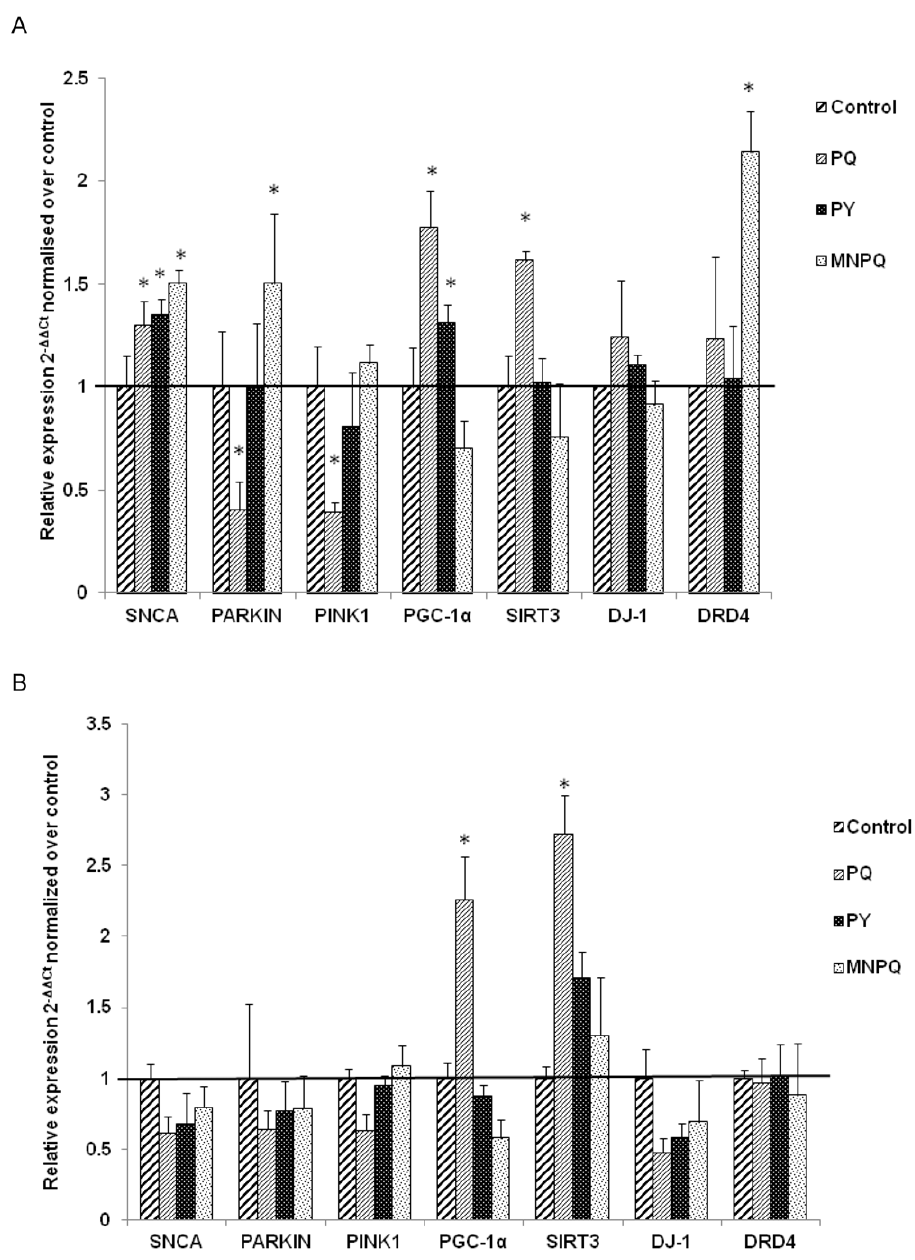
Figure 2. Validation of RNA-Seq gene expression fold changes by Taqman real time PCR. A) Gene expression fold changes in VMB. B) Gene expression fold changes in the